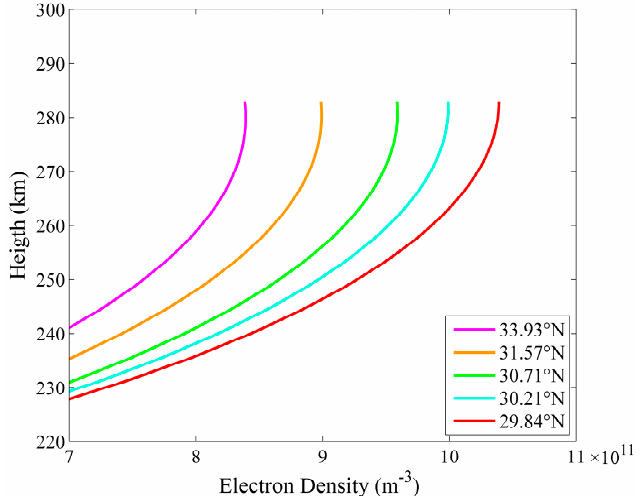
Figure 14. The electron density profiles in the five locations of the same longitude (112.77° E) and different latitudes (29.84 ˝ N, 30.21 ˝ N, 30.71 ˝ N, 31.57 ˝ N, 33.93 ˝ N).